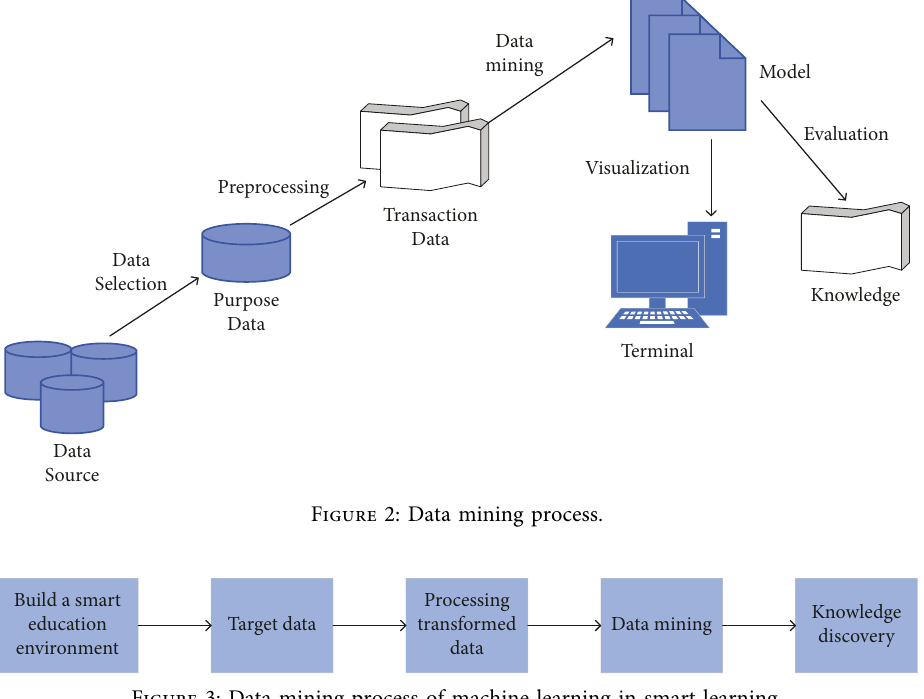
Figure 2: Data mining